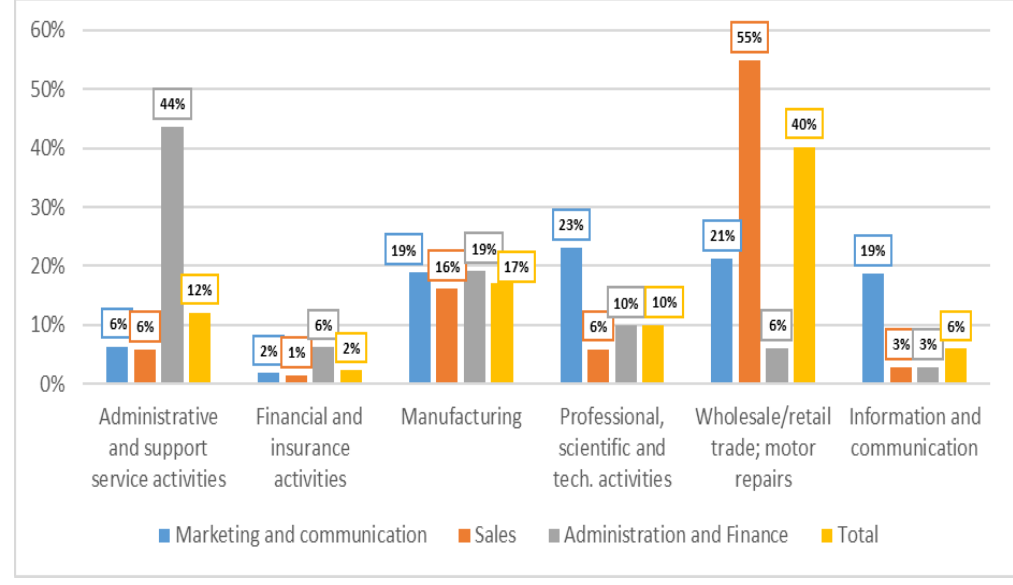
Figure 5: Sector of Vacancies by Area and